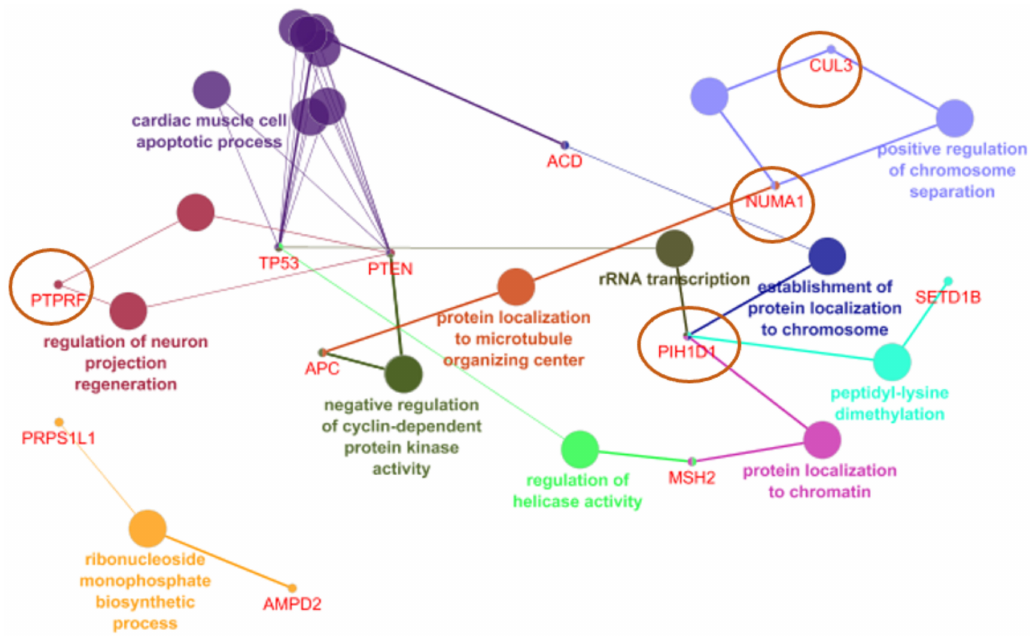
Figure 2. NCR genes and their association with rectal cancer related genes in CLUEGO.